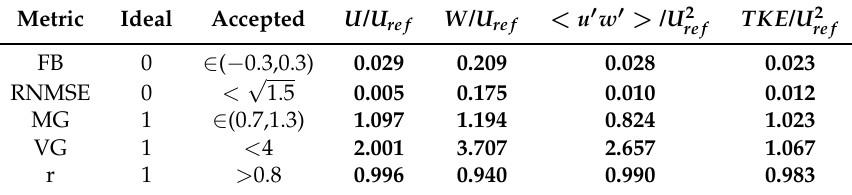
Table 3. General metrics applied to PIVa and